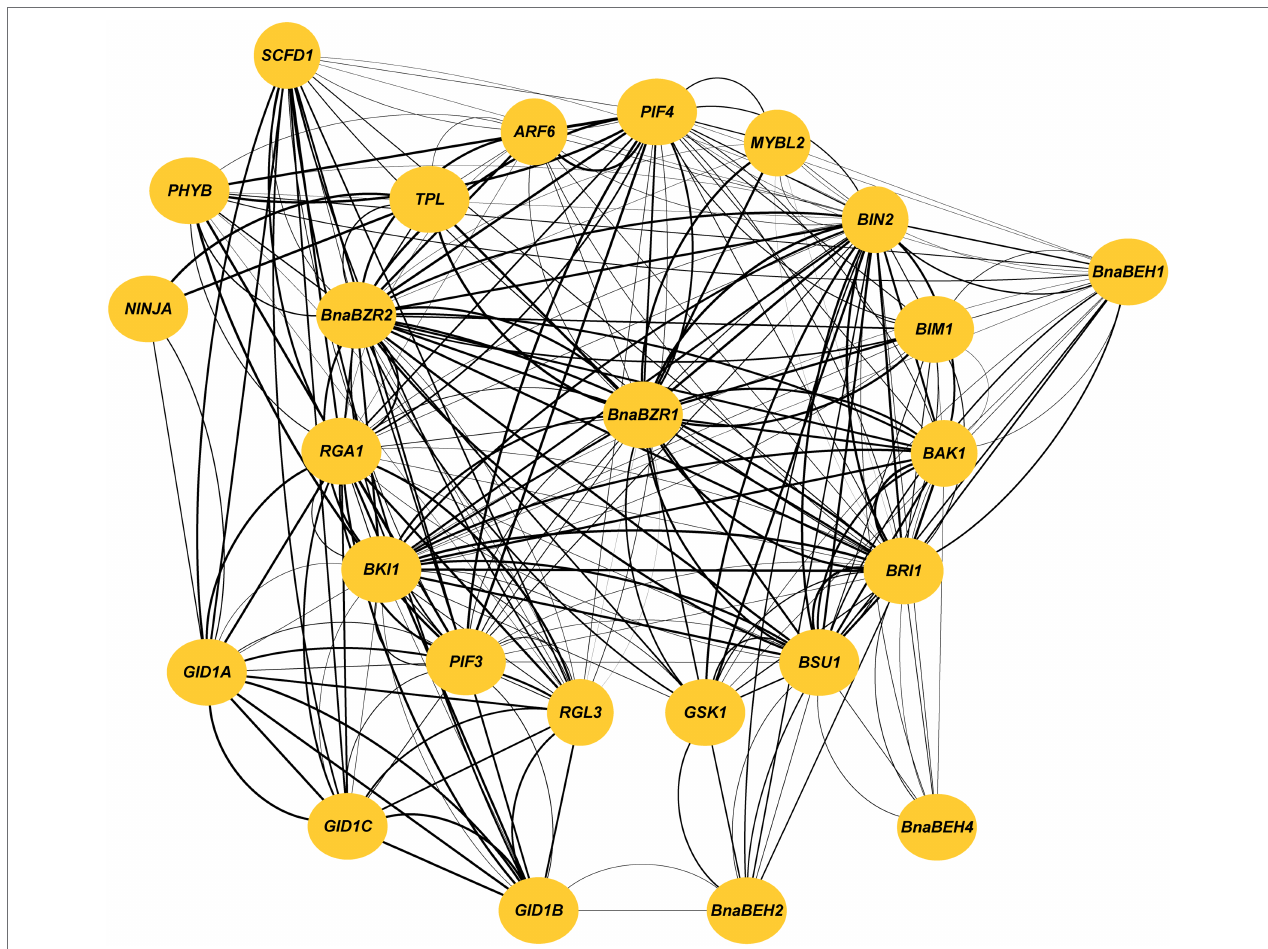
( Supplementary Figure S4A ). For instance, BnaC01BEH3 , BnaA03BEH2 , and BnaC07BEH2 contained the highest number of development-related, hormone-responsive, and light-responsive cis -elements, respectively. In contrast, BnaA06BZR1 contains